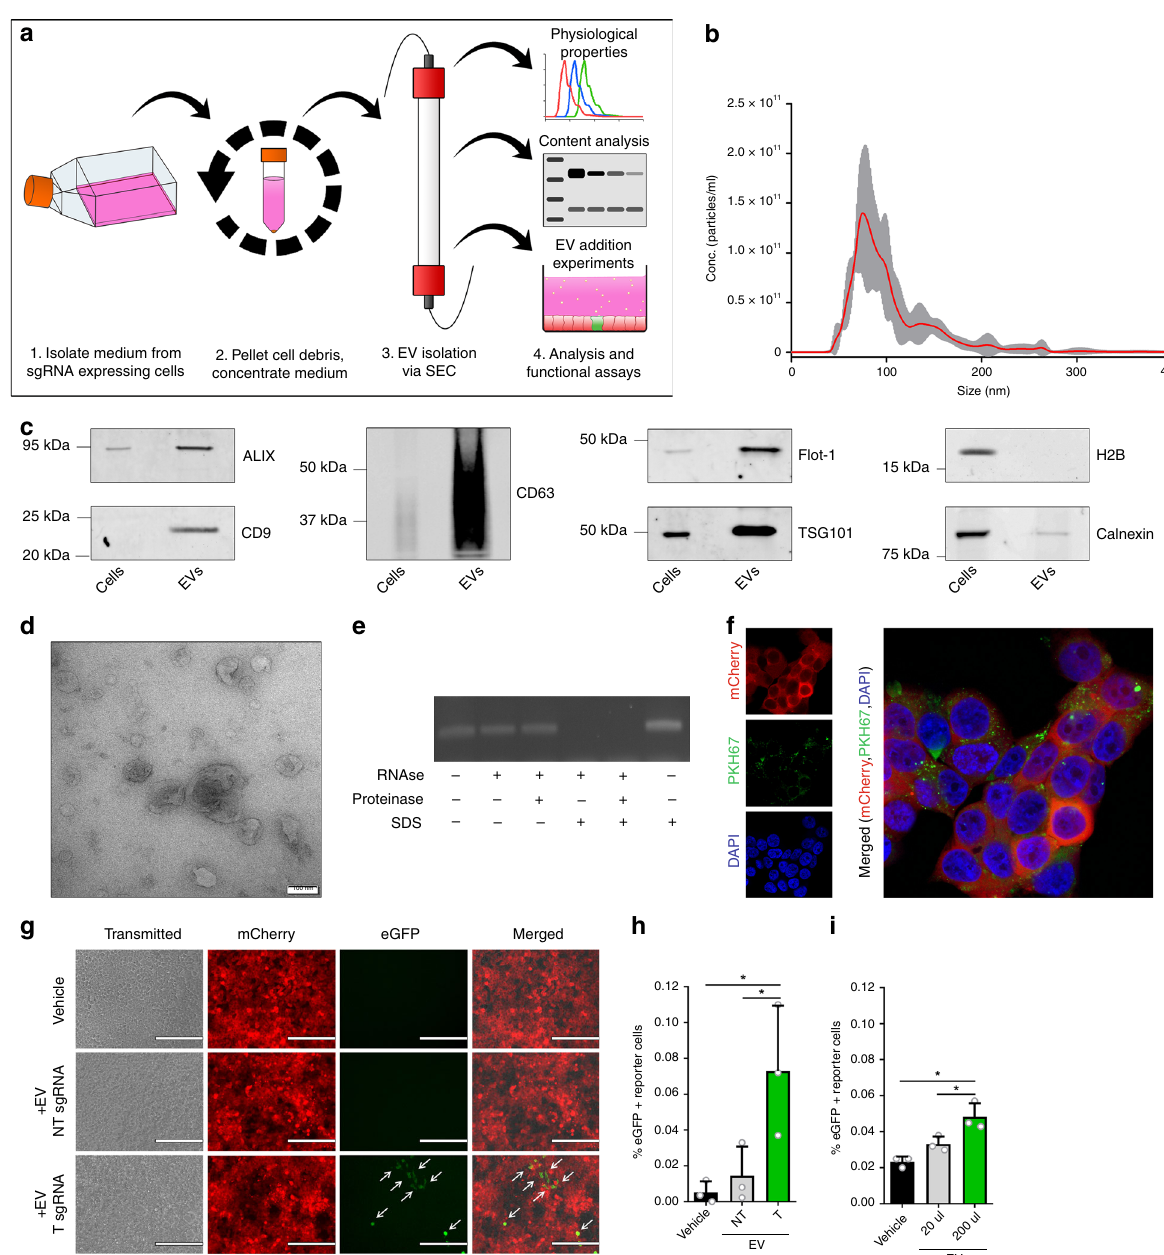
Fig. 3 Intercellular sgRNA exchange is EV-mediated. a Schematic of EV isolation work fl ow and analysis. Conditioned medium is isolated from sgRNA + MDA-MB-231 donor cells, after which cell debris is pelleted through centrifugation. Conditioned medium is then concentrated by tangential fl ow fi ltration, followed by size exclusion chromatography-mediated EV isolation. EVs are then characterized, and used for EV addition experiments in Stoplight + spCas9 + reporter cells. b Nanosight Nanoparticle Tracking Analysis (NTA) showing the size distribution of the isolated EVs (mode = 81 ± 3 nm). c Western blot analysis of EVs and cell lysates for common EV markers (CD9, CD63, ALIX, Flot-1, and TSG101), and EV-negative markers Calnexin and H2B. Representative images as observed in three independent experiments. d Electron microscopy analysis of isolated EVs. Scale bar represents 100 nm. Representative image as observed in 12 separate fi elds. e An EV RNase protection assay, followed by RT-PCR sgRNAs, shows that sgRNAs are only susceptible to RNase-mediated degradation in the presence of the membrane-disrupting anionic surfactant SDS. Representative data as observed in three independent experiments. f Confocal microscopy images of HEK293T reporter cells (red) that have taken up MDA-MB-231-derived PKH67-labeled EVs (green). Representative image as observed in seven randomly selected fi elds. g , h EV-mediated activation of the CROSS-FIRE platform using EVs isolated from sgRNA + MDA-MB-231 donor cells. EVs were added every 72 h for 12 additions with an average dose of 1.1e11 ± 4.9e10 EVs per addition. Cells were analyzed by fl uorescence microscopy ( g ) and fl ow cytometry ( h ). Scale bar represents 200 µ m. Means + SD, n = 3 biological replicates, Tukey ’ s multiple comparison test. i EVs from sgRNA + MDA-MB-231 donor cells activate Stoplight + spCas9 + HEK293T reporter cells in a dose-dependent manner. EVs were added every 72 h for nine additions with an average concentration of 2.2e10± 1e10 (20 µ l) or 2.2e11 ± 1e11 (200 µ l). Means + SD, n = 3 biological replicates, Tukey ’ s multiple comparison test. * p <